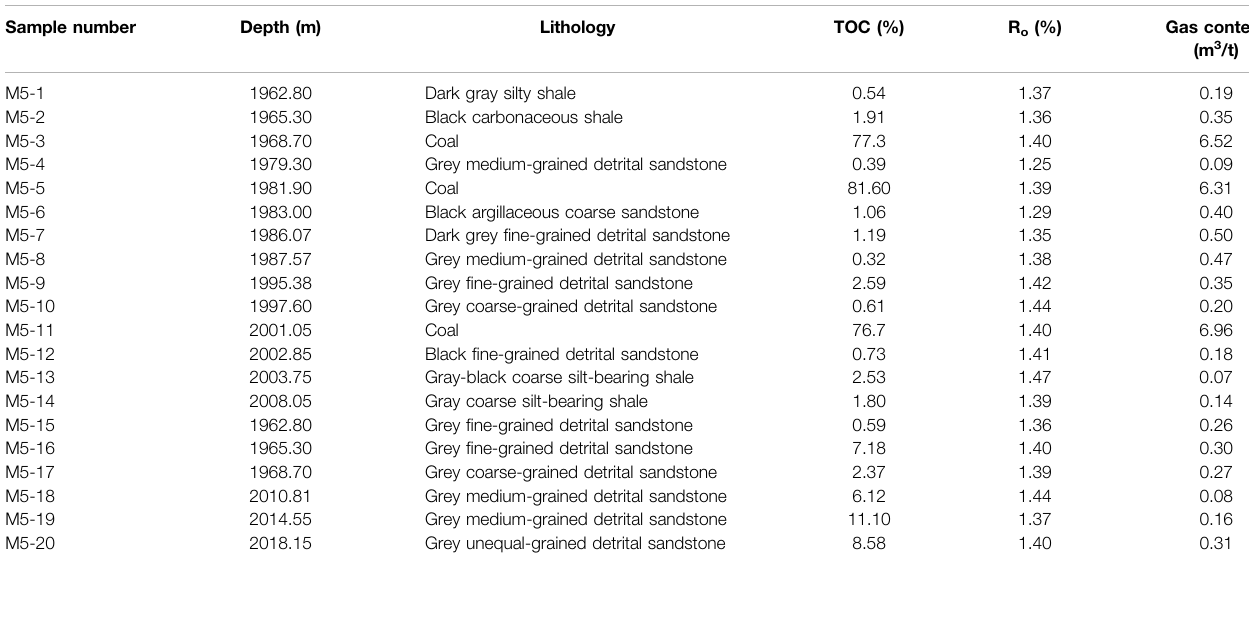
TABLE 1 | Test results of organic geochemical parameters and gas-bearing properties of coal-measure samples collected from the Shanxi Formation in the study area. Sample number Depth (m) Lithology TOC (%) R o (%) Gas content